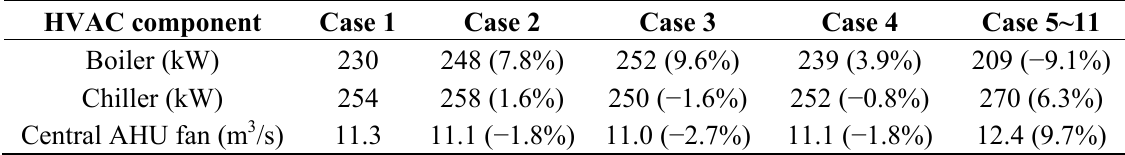
Table 6. HVAC system size and percentage